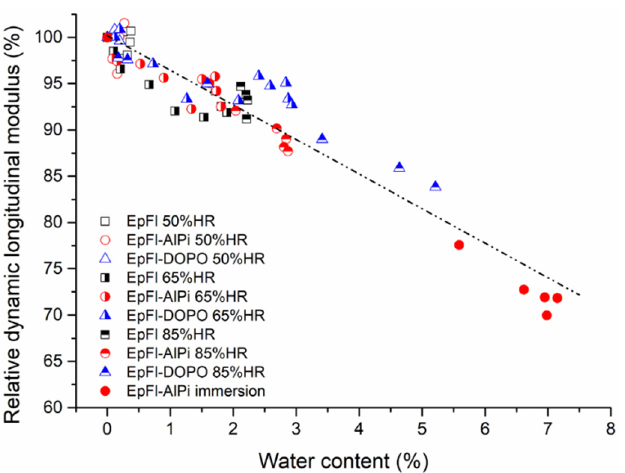
Figure 8. Relative dynamic longitudinal modulus versus water content for series aged at 70